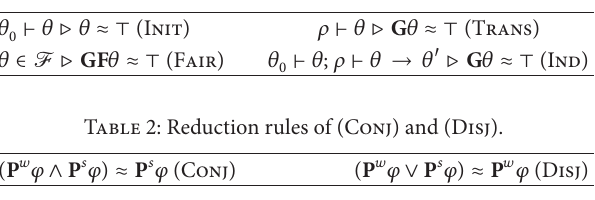
Table 1: Reduction rules about model components.